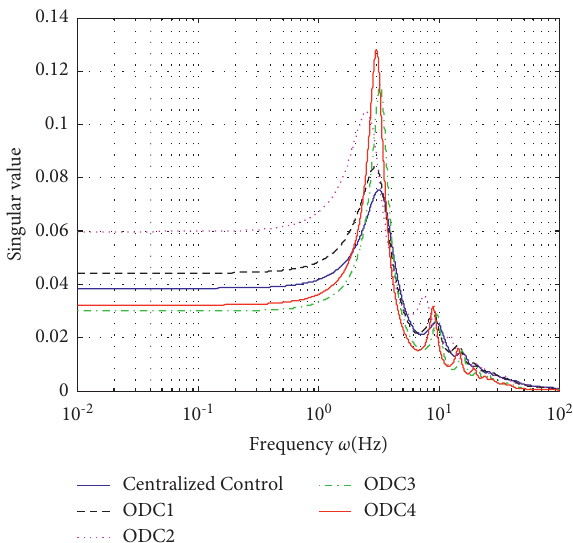
Figure 9: The maximum interstory displacements of time delay τ � 40ms.